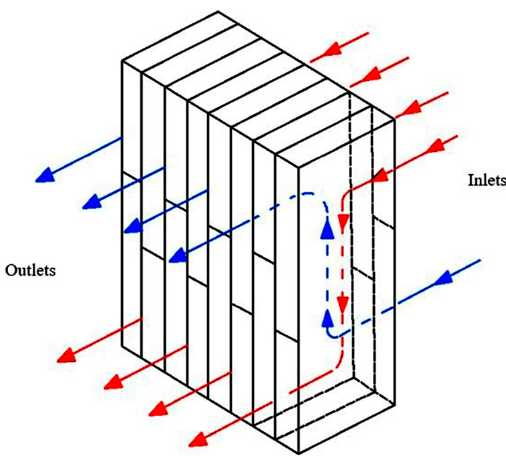
Figure 6 . Z-flow fixed-plate heat exchanger (HE) built using porous membrane material [21] . Figure 6. Z-flow fixed-plate heat exchanger (HE) built using porous membrane material